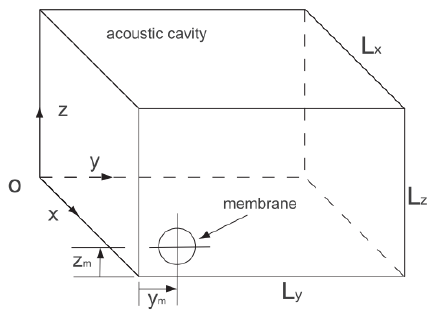
Figure 1. Schema of the system of a 3D cavity and a nonlinear membrane.